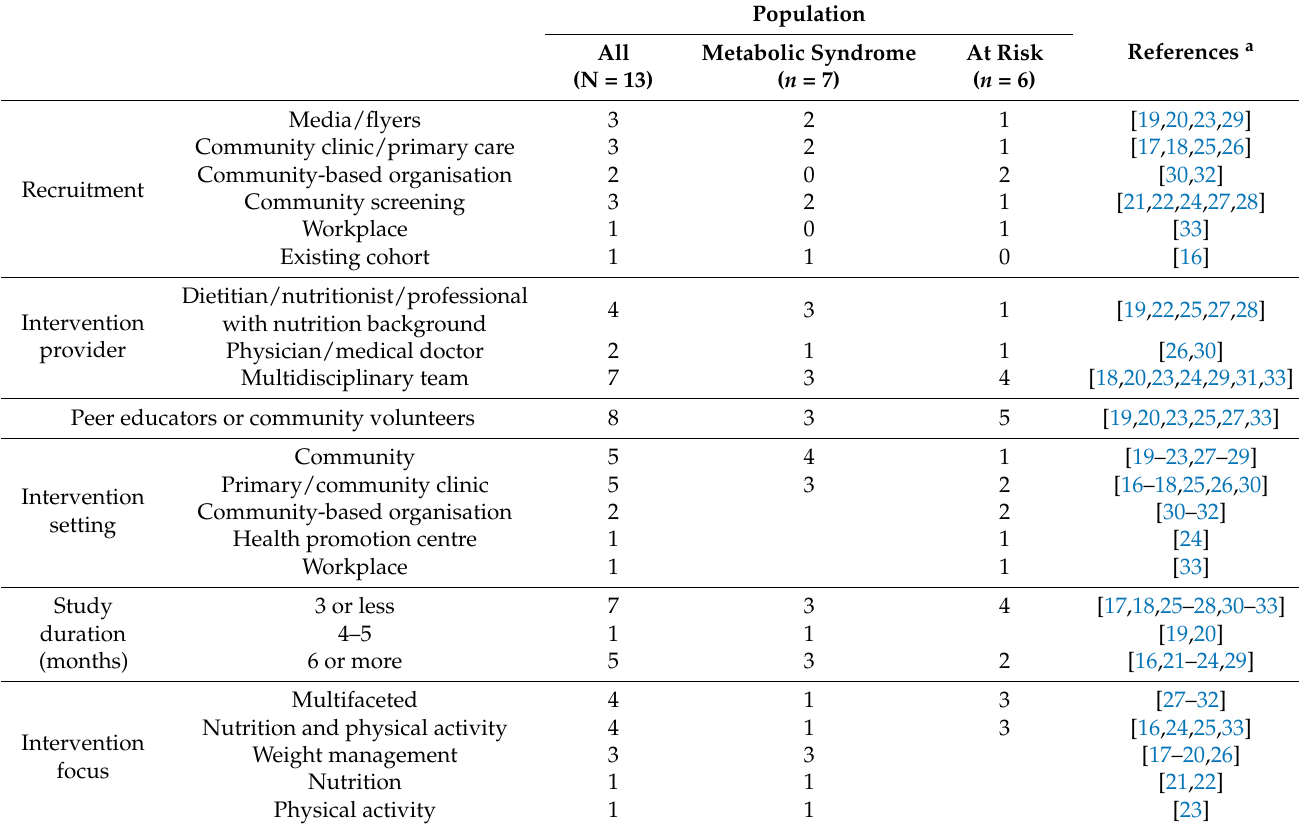
Table 2. Intervention characteristics of the included studies (N =